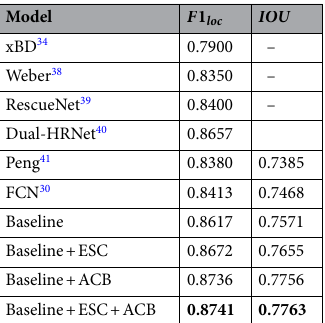
Figure 6. Visualization of building segmentation results.